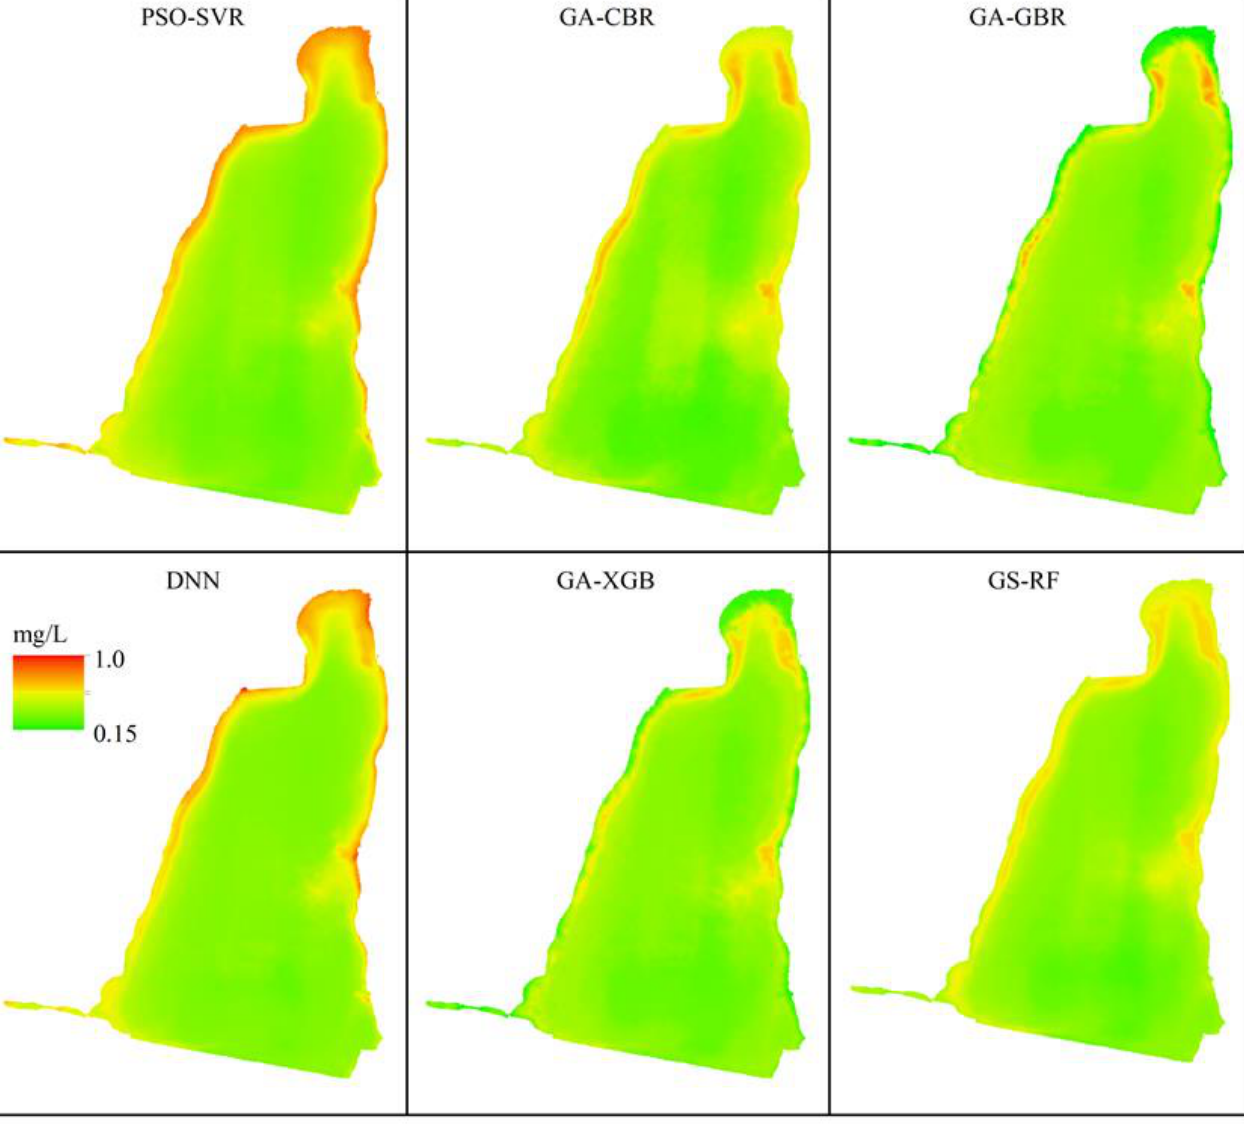
Figure 6. Spatial distribution of TP concentration derived from the six IOA-ML models in research area B.